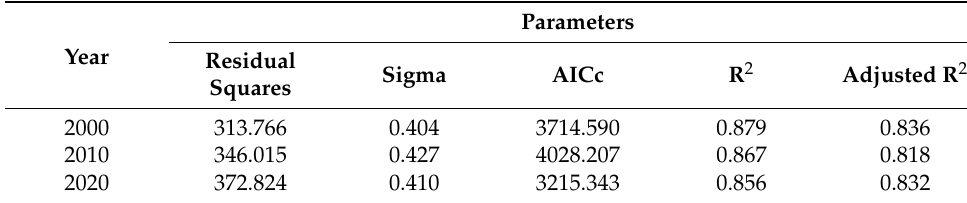
Table 5. Estimation parameters for GWR models.